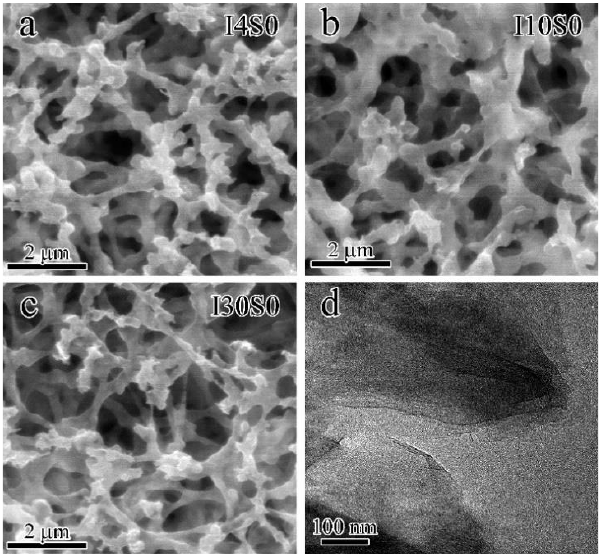
Figure 15. The SEM images (( a ) I4S0; ( b ) I10S0; ( c ) I30S0) and TEM image ( d ) of specimens recycled from tap water electrolyte.